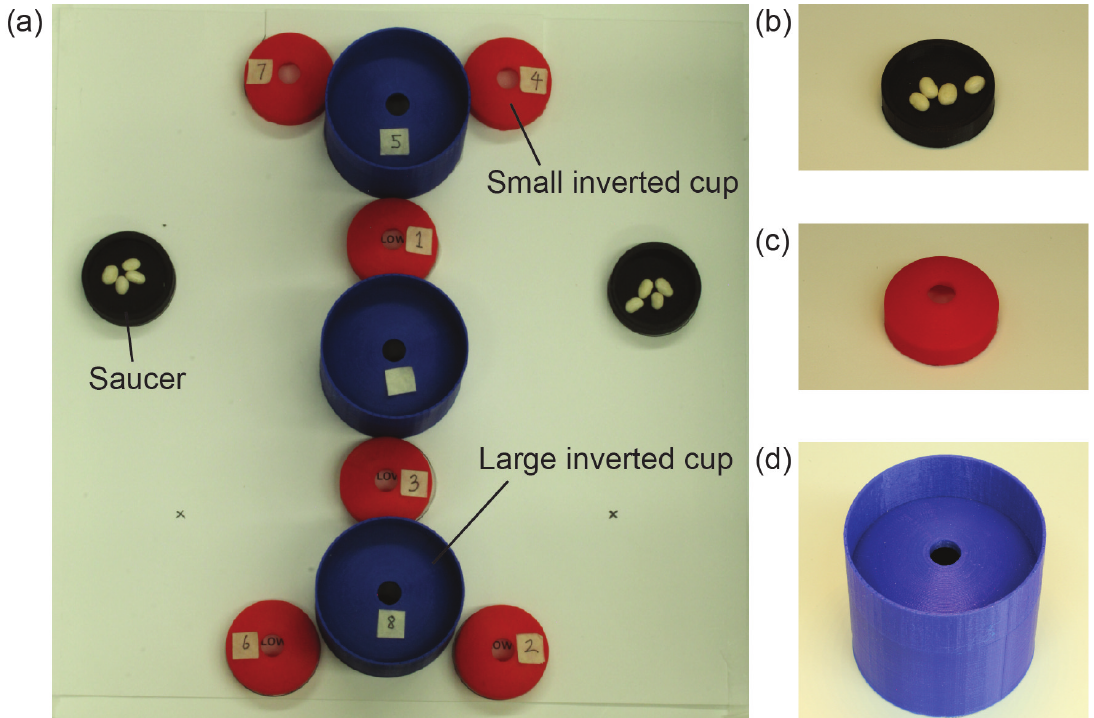
Figure 5. Modified Bean Drop: Our modified bean drop task consisted of 2 saucers with a diameter of 40 mm ( b ), 6 small inverted cups with diameters of 40 mm ( c ), and 3 large inverted cups with diameters of 62 mm ( d ), all placed in the pattern shown in ( a ). This pattern was designed to be large enough that it cannot be fully seen with the traditional laparoscope to emphasize the increased FoV offered by the micro-camera array. The traditional laparoscope needs to survey the scene being able to complete the task and occluding elements made the survey